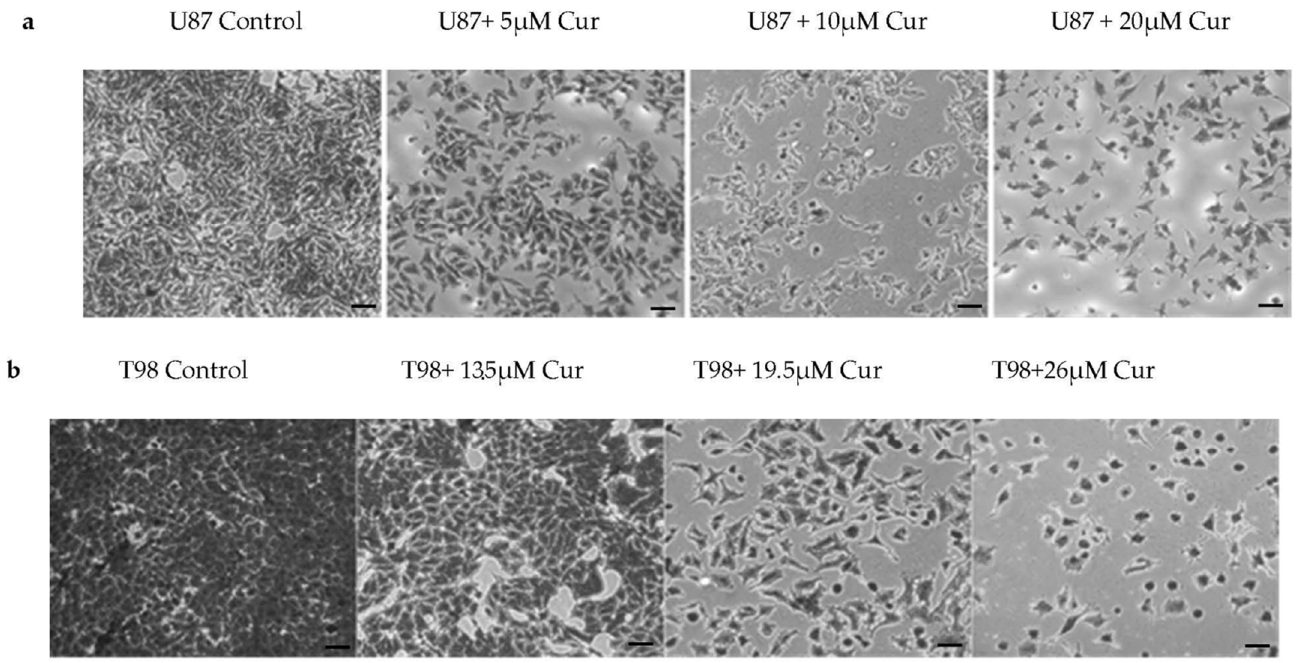
Figure 2. Cytotoxic effect of curcumin on glioblastoma cell lines U87 and T98 at 72 h. Values shown are the means and standard deviations from three independent experiments and are normalized to non-treated cells ( p < 0.05 vs. control). The IC50 values were determined using the non-linear regression analysis model of GraphPad Prism Version 8.